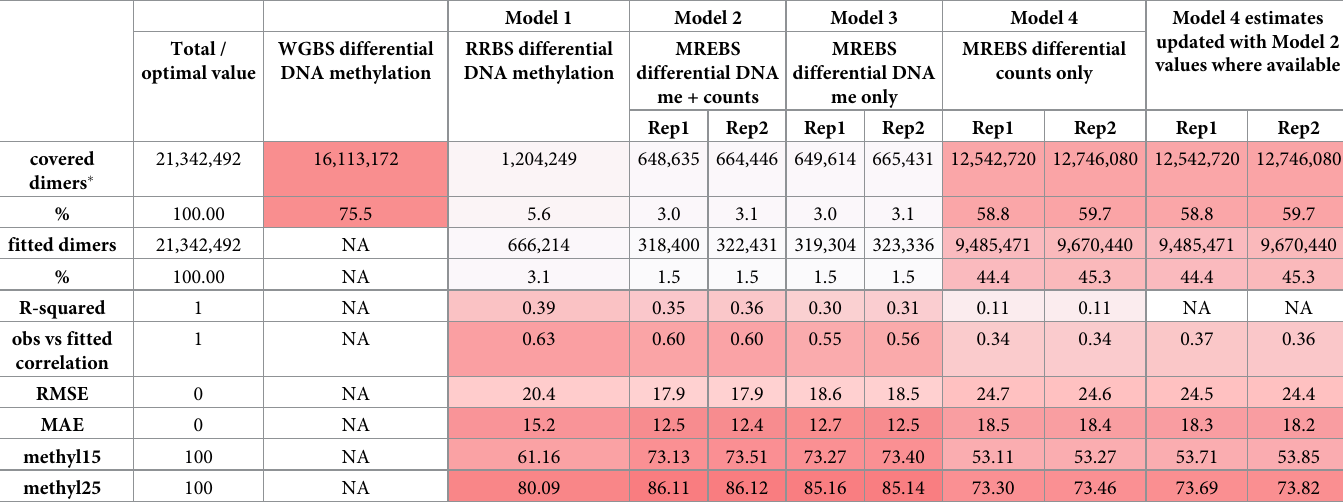
Table 3. Differential DNA methylation model metrics. The table gives metrics (first column) for four different models, as well as a combined model, (top row and described in the text). The column labeled ‘Total / optimal value’ gives the maximum or best value achievable for each metric. The column labeled ‘WGBS differential DNA methylation’ provides coverage information for comparison purposes. � Note: In the case methylation levels, only CpG dimers with 5X coverage in both EARLY intermediates and ESCs were considered. With respect to counts, CpG dimes with 2+ reads in the surrounding 1Kb bin, in at least one sample, were considered. Red inten- sity signifies how close the metrics are to the optimal values.